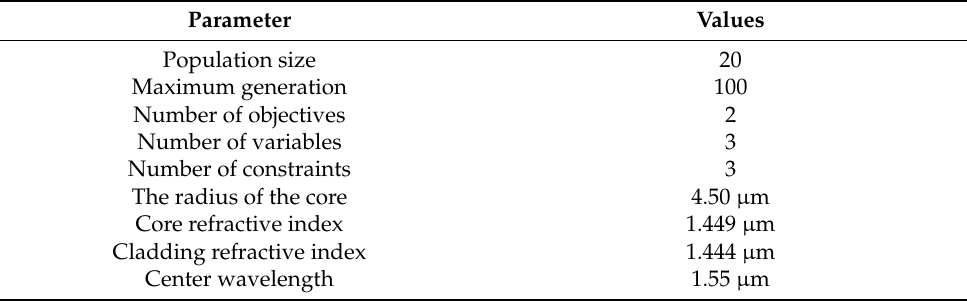
Table 1. The testing parameters of